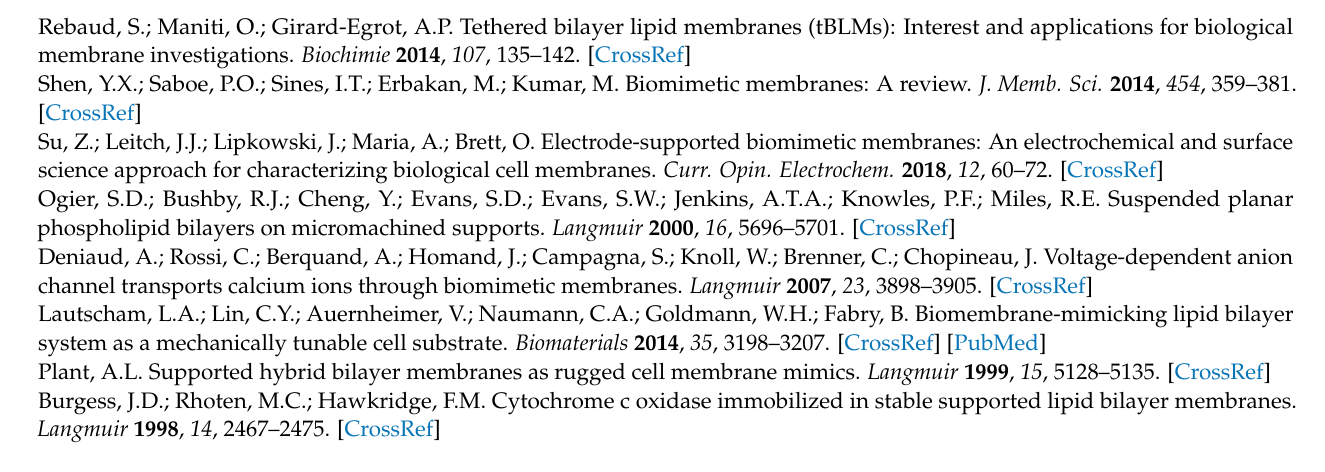
Table S3: The values of simulated equivalent circuit elements of Nyquist plots shown in Figure